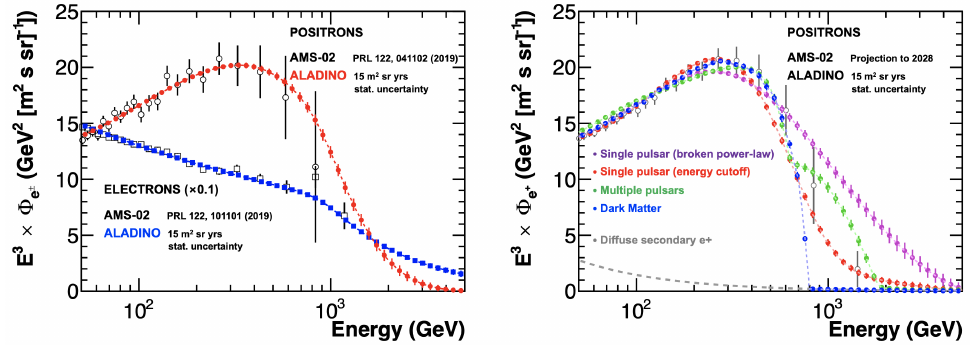
Figure 4. Left: Projected measurement of ALADInO after a 5-year data collection operation for the e ± fluxes in the descriptive model of [46,104] with a TeV break compatible with observations of[34]. Fluxes are multiplied by E 3 and the e − flux is scaled down by a factor of 10 for display purposes. Right: Projected measurement of ALADInO after a 5-year data collection operation for the e + flux in 4 different scenarios invoking astrophysical and DM origin of high-energy e + (violet and red from[105], green from[106], and blue from [67]) compared with the flux expected only from the e + diffuse secondary component (gray from[46]) and with the projections for AMS-02 to 2028[4]. The accuracy of ALADInO data in the supra-TeV region will allow to disentangle the dominating source of high-energy e ± and to measure directly the properties of the high-energy diffuse secondary component of e + CRs. Figure readapted from[96] under license CC BY